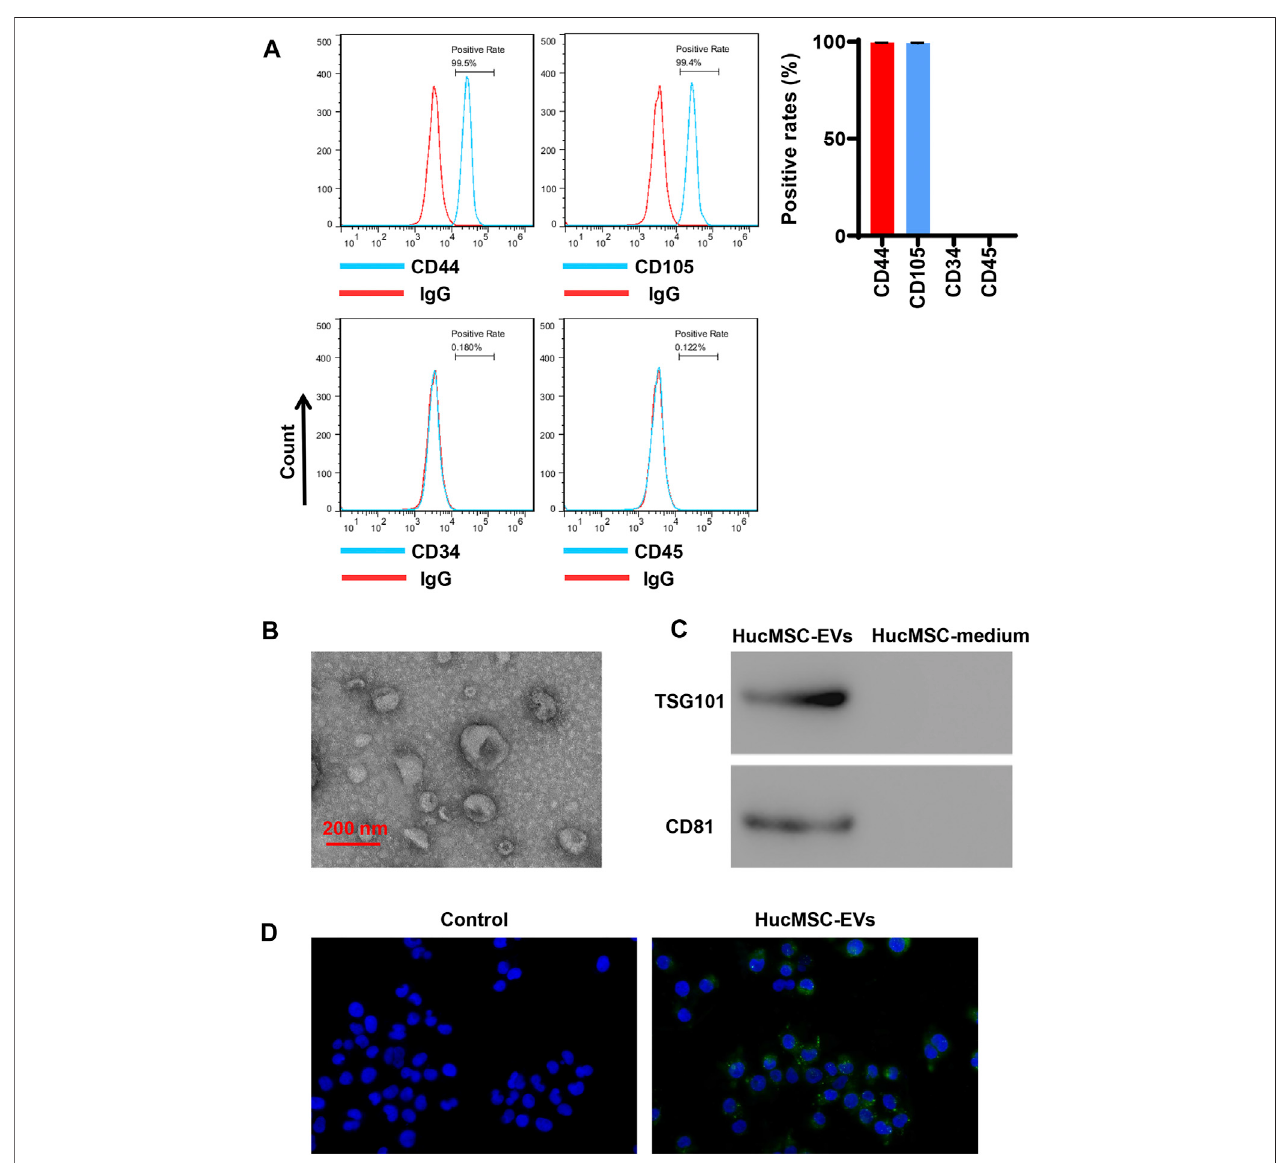
FIGURE 1 | Isolation and identi fi cation of HucMSC-EVs. (A) The surface markers CD44 and CD105 of HucMSCs were identi fi ed by fl ow cytometry. (B) The morphologyofpuri fi edHucMSC-EVswasobservedbytransmissionelectronmicroscopy:scalebar:200 nm. (C) ThemarkersCD81andTSG101ofHucMSC-EVswere detected by Western blot. (D) HucMSC-EV endocytosis traced by PKH67 was observed by a laser scanning microscope in AC16 cells.